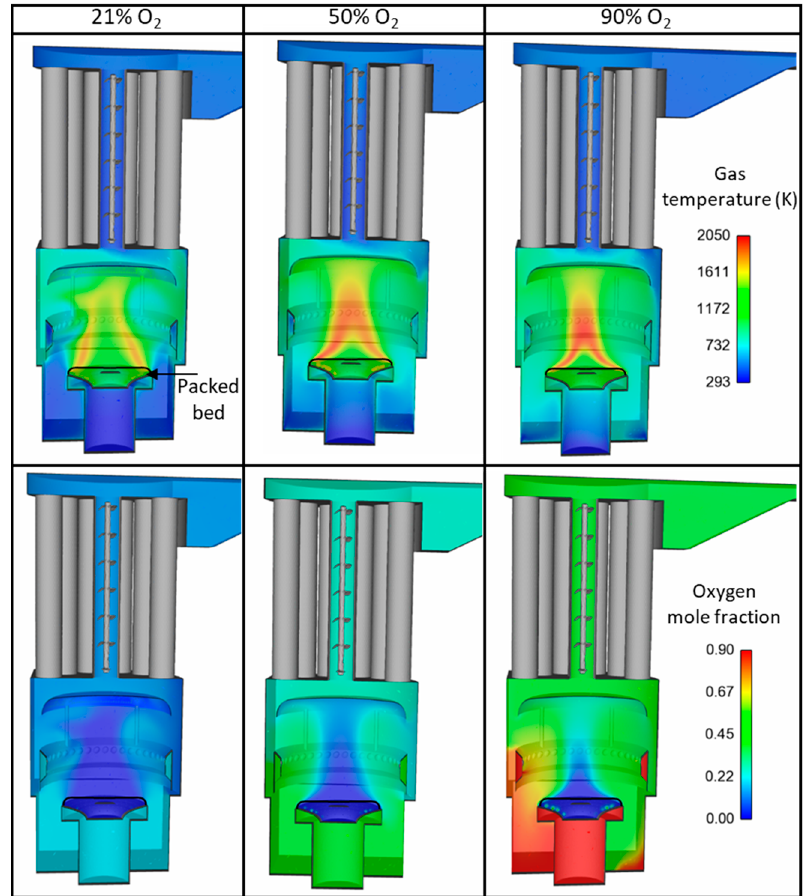
Figure 7. Contours of the gas temperature and oxygen concentration inside the boiler for the simulations of 21%, 50%, and 90% of oxygen in the inlets.